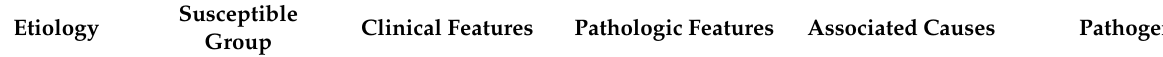
Table 2. The susceptible group, clinical features, pathological features, associated causes and patho- genesis of common pigmentation